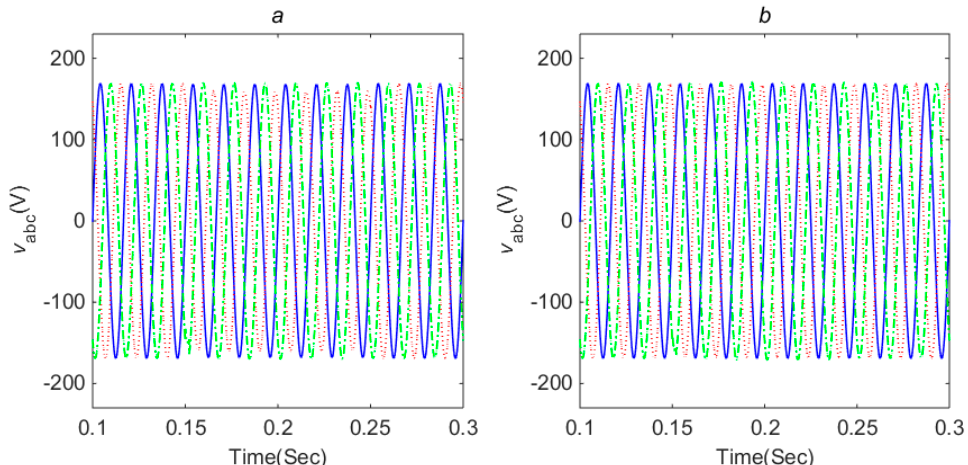
Figure 5. Load voltage ( a is under RHOSM and b is under AHOSM).